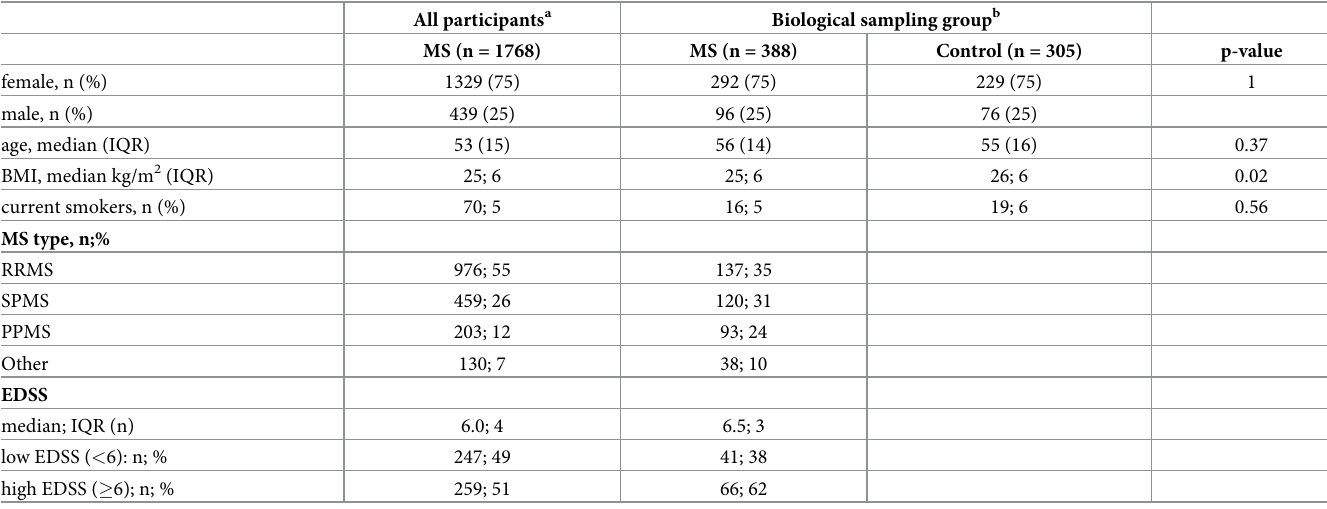
Table 1. Participant demographics. All participants a Biological sampling group